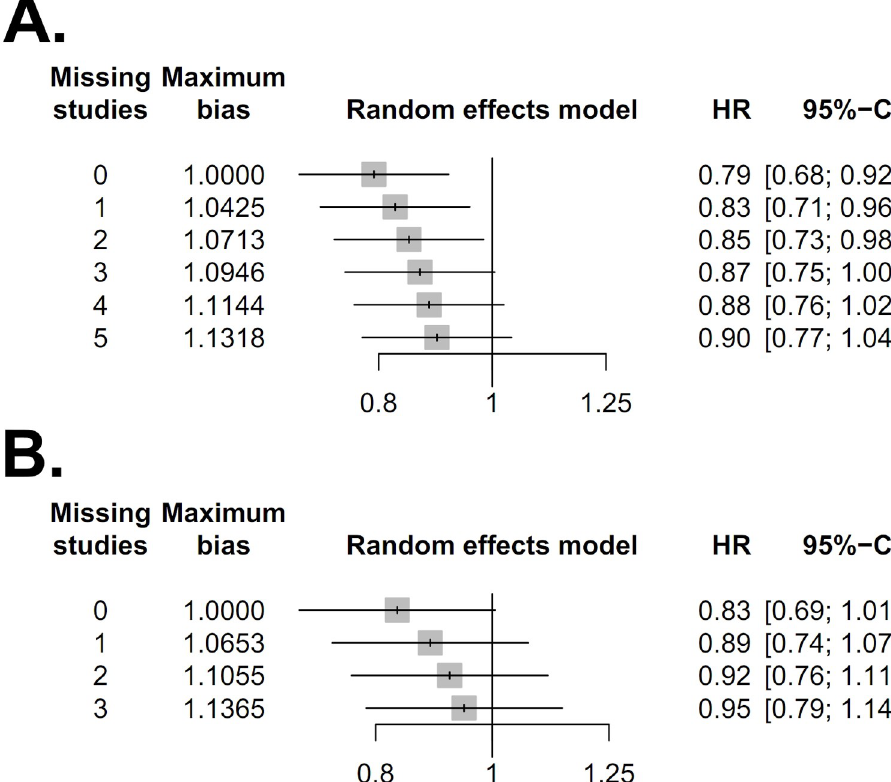
Fig 4. Sensitivity analysis for the outcome reporting bias (ORB) of patients with T2-4aN0M0 MIBC (A) and patients with T2N0M0 MIBC(B). The sensitivity was considered robust in the sensitivity analysis for ORB.